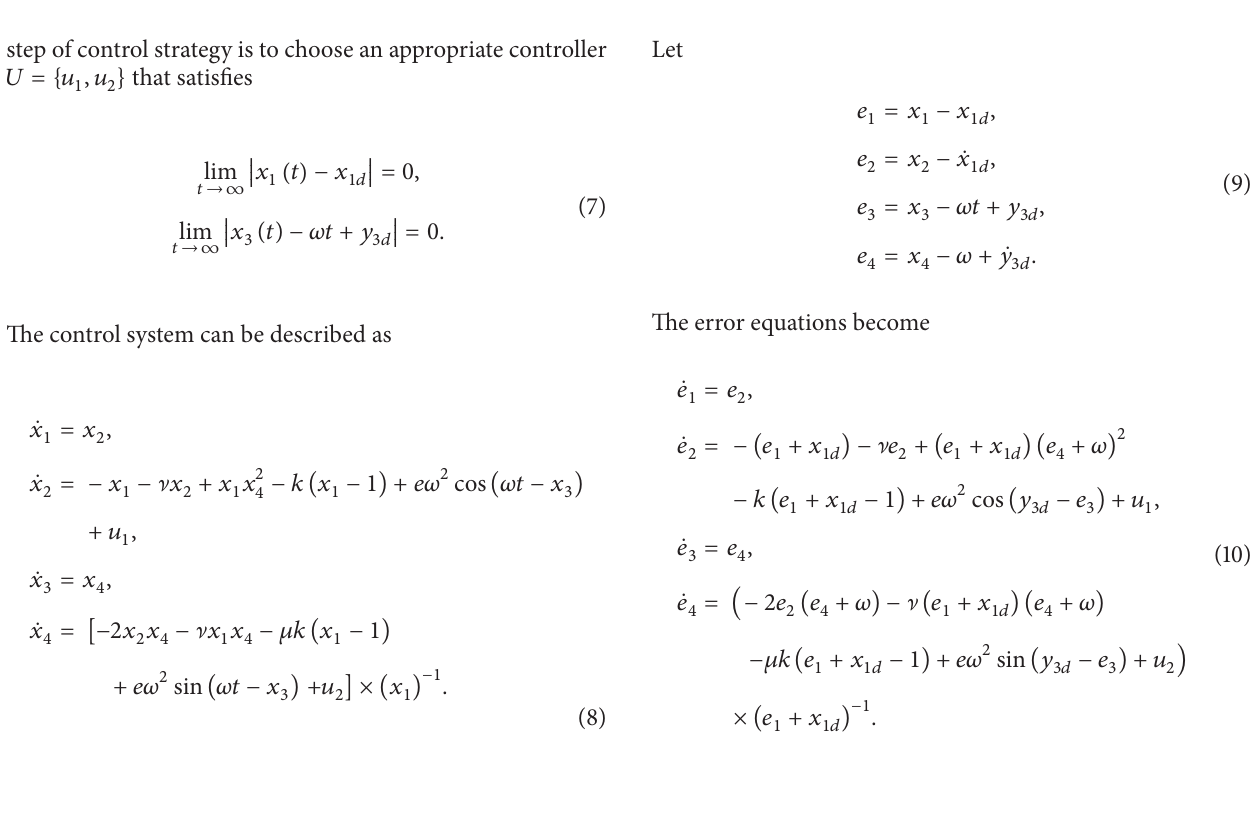
step of control strategy is to choose an appropriate controller 𝑈 =